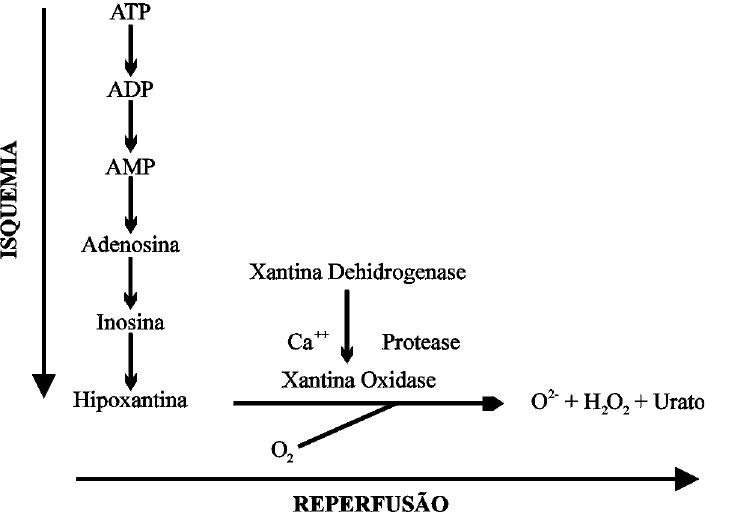
Figura 1 - Mecanismo proposto para geração de radicais livres de oxigênio após períodos de isquemia e reperfusão 4,5,6